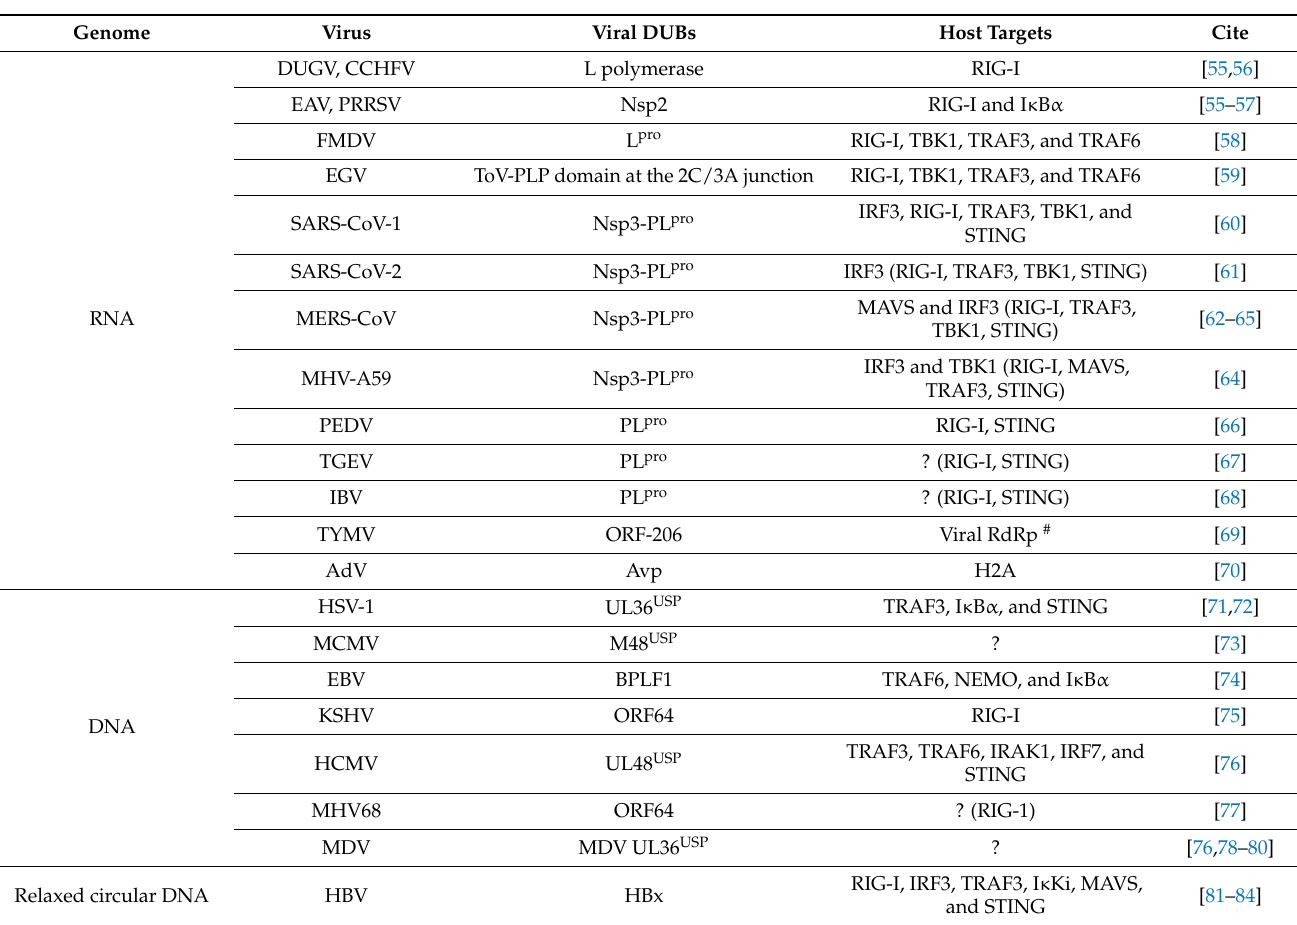
Table 1. Viral DUBs and their cellular targets. # and ? indicate viral target or unknown host target, respectively. Host targets in parentheses indicate potential targets based on homology among viral DUBs and/or identified regulation/interaction that has not yet been attributed to DUB activity. Abbv: DUGV—Dugbe virus; CCHFV—Crimean-Congo hemorrhagic